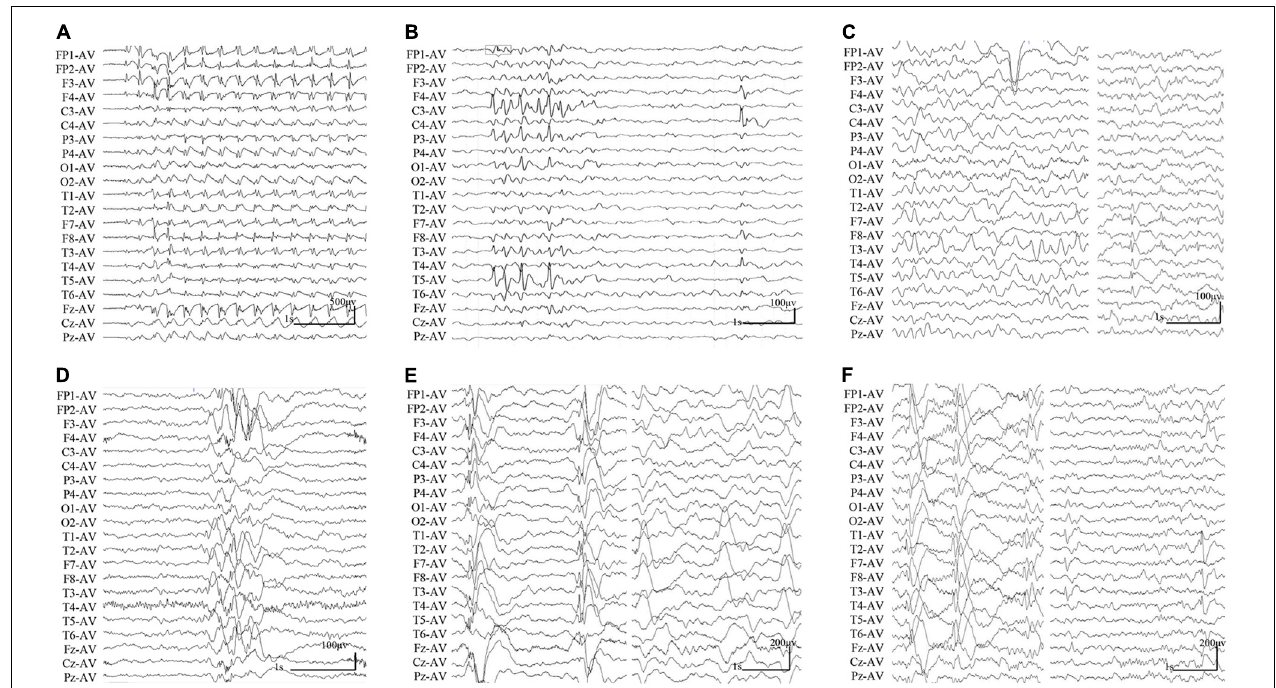
FIGURE 2 | Changes of interictal EEGs and MRI in the cases with SHROOM4 variants. (A) Interictal EEG of case 1 showed 3 Hz generalized spike-slow waves (obtained at the age of 7 years). (B) Interictal EEG of case 2 showed bilateral central-temporal independent sharp waves and spikes (obtained at the age of 7 years). (C) Interictal EEG of case 3 showed generalized slow waves and left temporal spike-slow waves (obtained at the age of 14 years). (D) Interictal EEG of case 4 showed irregular generalized spike-slow waves (obtained at the age of 16 years). (E) Interictal EEG of case 5 showed irregular polyspike-slow waves and bilateral temporal independent spike-slow waves (obtained at the age of 4 years). (F) Interictal EEG of case 6 showed right predominant generalized spike-slow waves, bilateral temporal independent spike-slow waves (obtained at the age of 3 years).